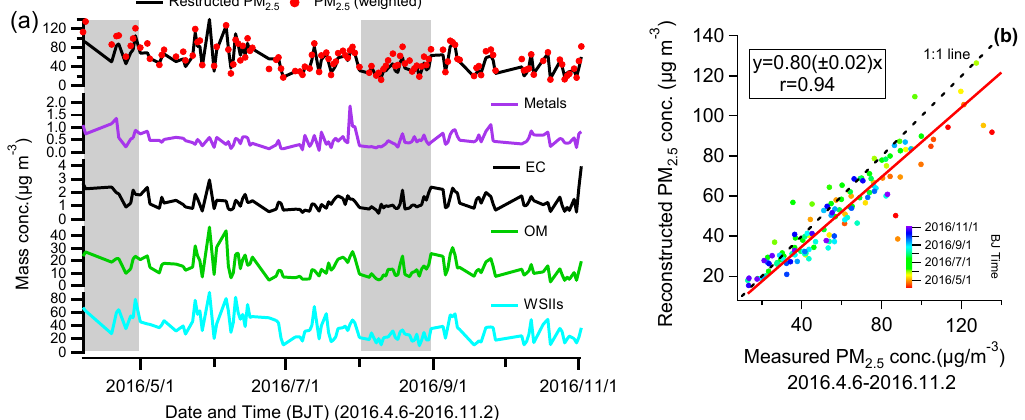
Figure 2. ( a ) Time series of total particular matter (PM 2.5 ) and major components, and ( b ) scatter plot of the reconstructed versus measured PM 2.5 mass concentrations (colored by time).